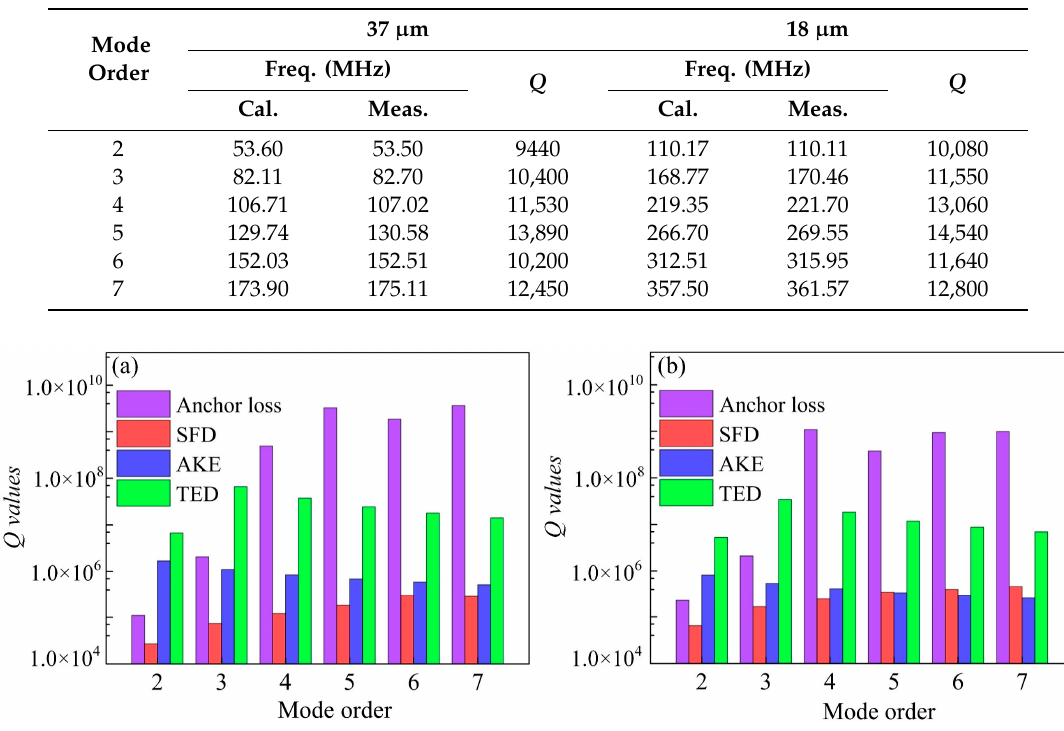
Table 2. The measured Q values of the 37 and 18 µ m-radius resonators vibrating in the atmosphere.